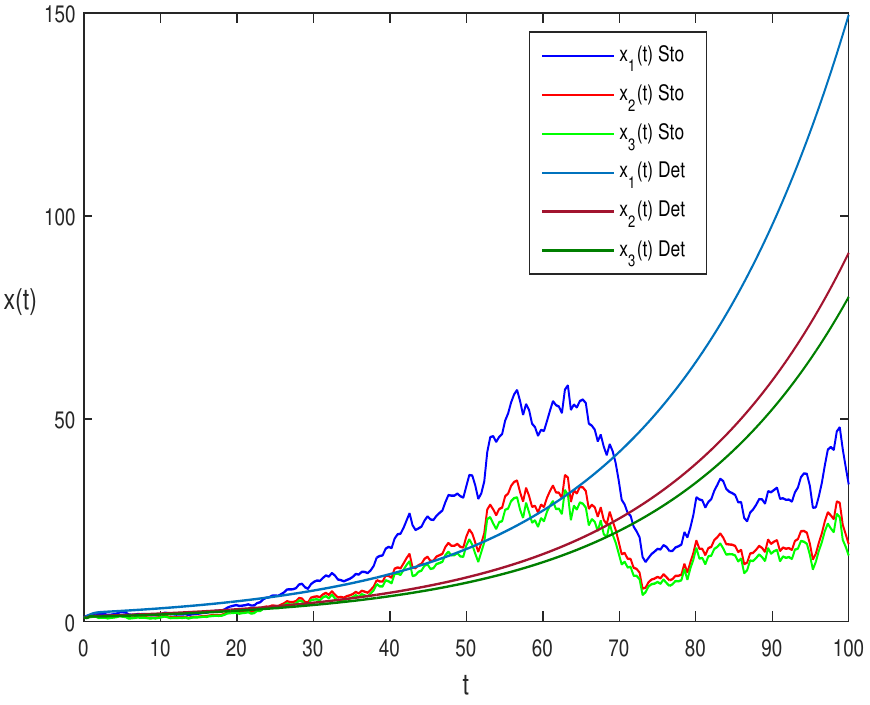
Figure 4. Comparisons of the unstable positive solutions for each class of stochastic delay NGM systems from Equation (1) with the deterministic model, σ i = 1, ( i = 1,2,3 )